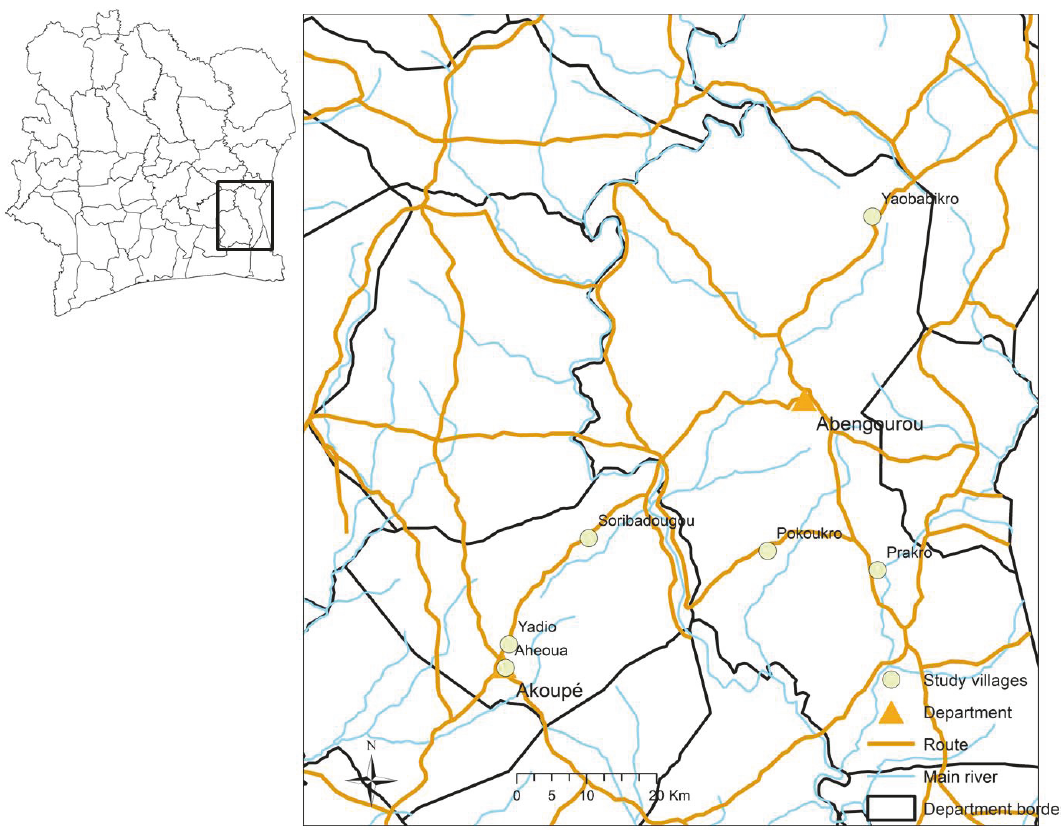
Figure 1: Map of study villages from the departments of Akoup´e and Abengourou in eastern Cˆote